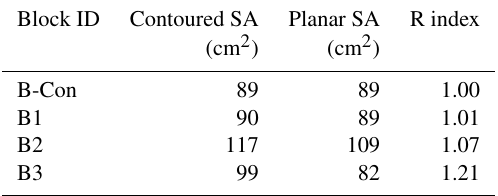
Table 2. Contoured surface area (SA), planar surface area, and ru- gosity index (RI) for each of the experimental